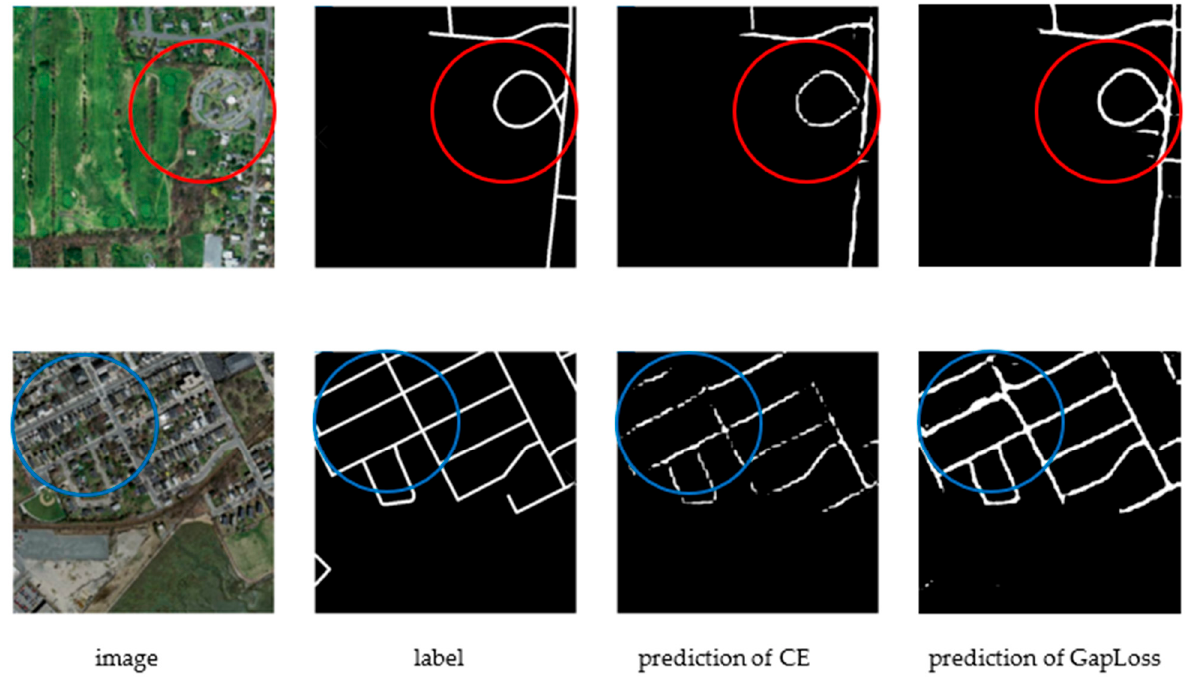
Figure 3. PSPNet results with CE and GapLoss on Massachusetts Roads Dataset. The blue and red circles indicate where the road continuity is improved after using GapLoss.